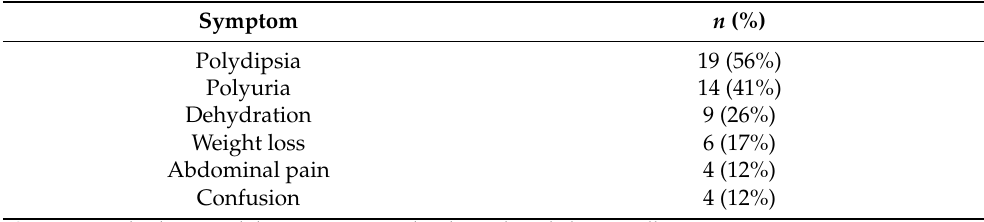
Table 2. Frequency of symptoms at presentation of ICI-induced IDDM in 34 patients. Symptom n (%) Polydipsia 19 (56%) Polyuria 14 (41%) Dehydration 9 (26%) Weight loss 6 (17%) Abdominal pain 4 (12%)